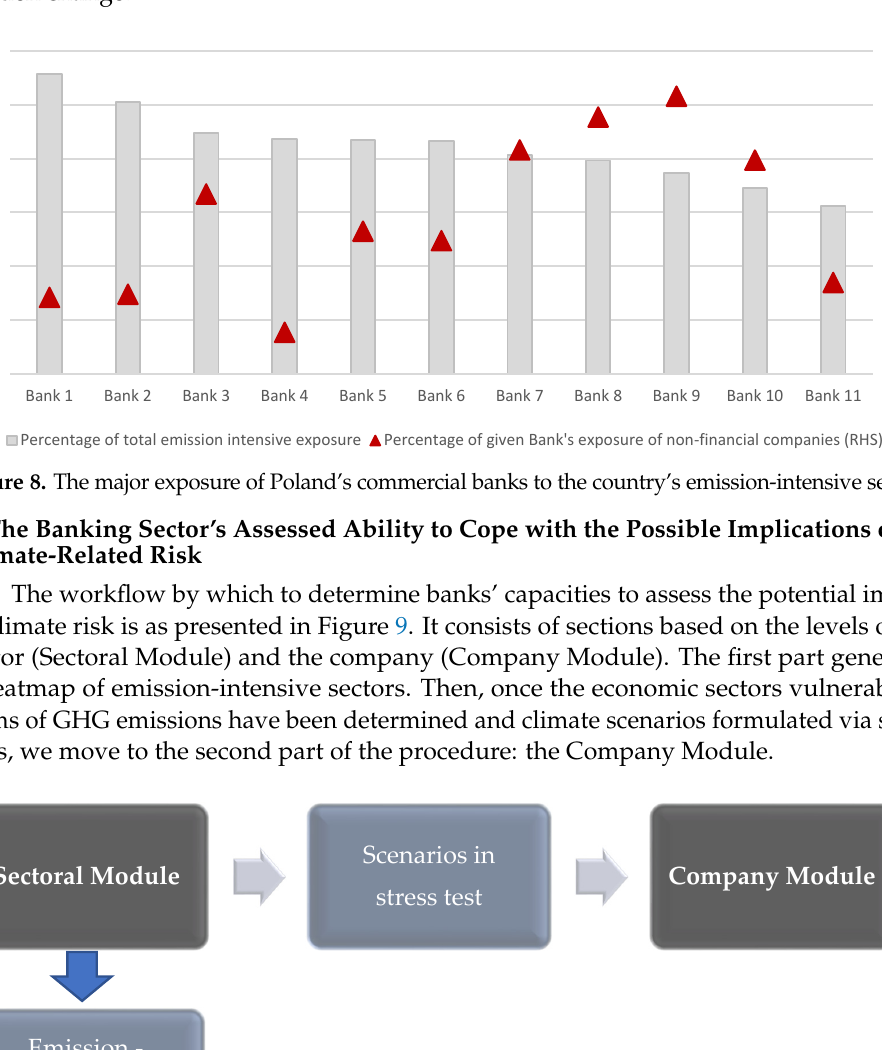
Figure 7. Bank loans and GVA of Poland’s emission-intensive economic sectors.